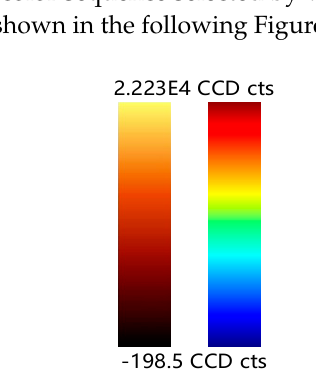
Figure 19. Pseudo-color sequence of Witec instrument (Left), pseudo-color sequence of this paper (Right).